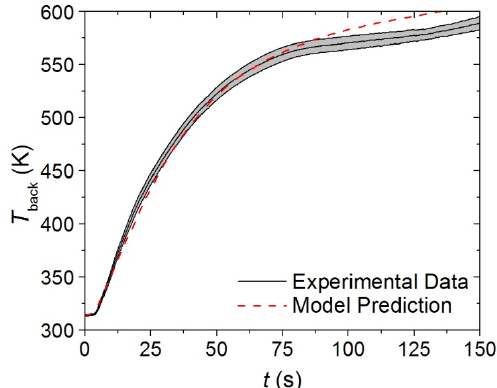
Figure 13. First 150 s of experimental T back curve measured in CAPA tests and corresponding model predicted curve for the base layer exposed to a radiant flux of 30 kW·m − 2 . The shaded region corresponds to two standard deviations of the mean experimental data.